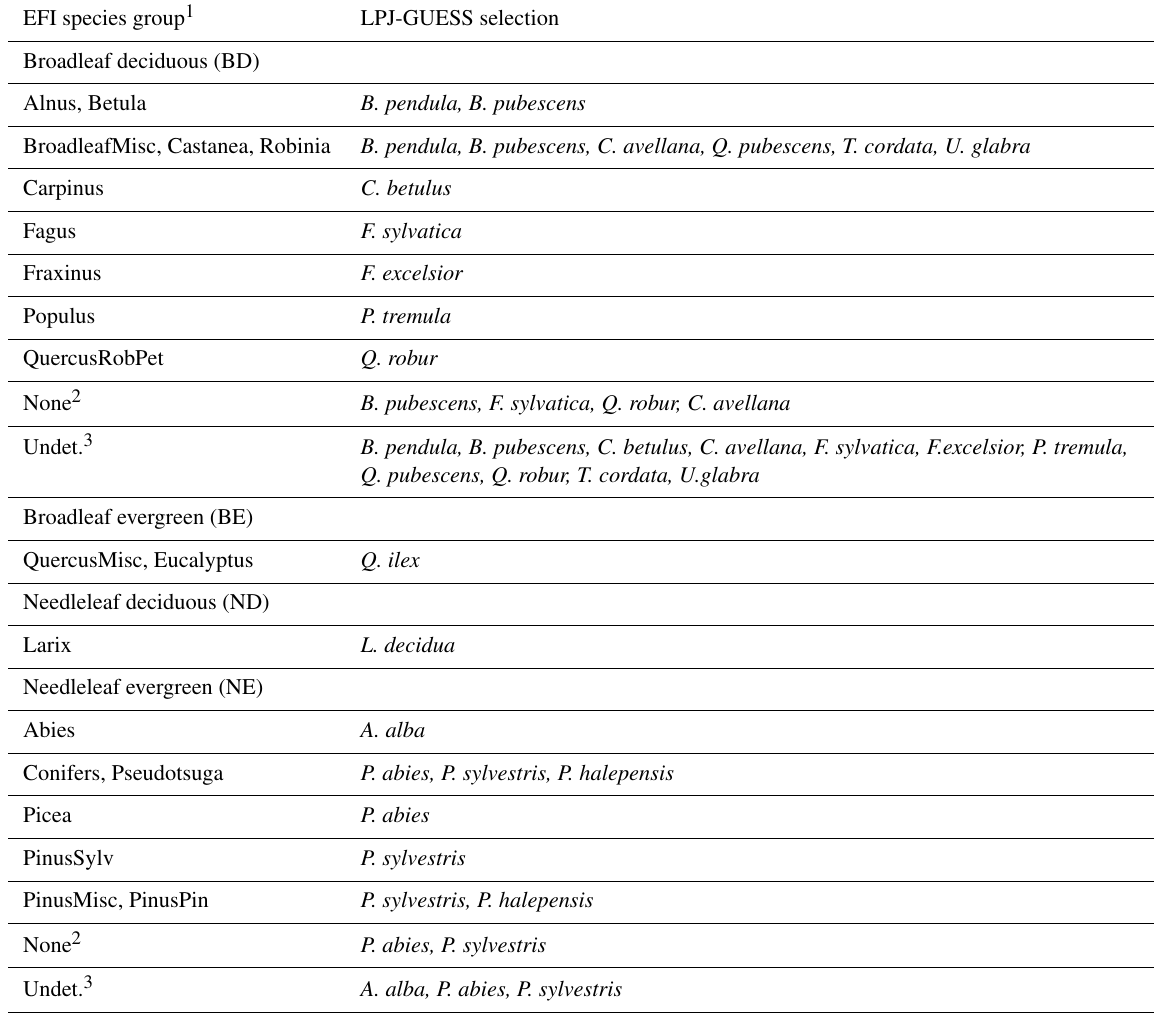
Table C1. Mapping of EFI tree groups to LPJ-GUESS species